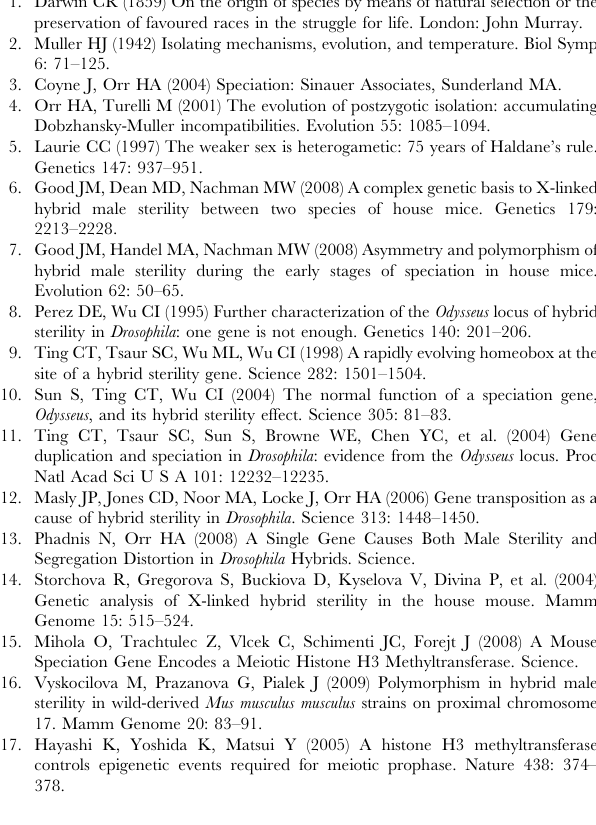
Figure S5 Multiple sequence alignment (shaded according to a 90% consensus) of 11 Capitella sp.I Prdm9 zinc finger sequences. These have been predicted from scaffold_236 of the Capitella sp.I v.1.0 genome assembly (Joint Genome Institute). Found at: doi:10.1371/journal.pgen.1000753.s005 (2.95 MB EPS) Figure S6 Multiple sequence alignment (shaded according to a 90% consensus) of Prdm9 zinc finger sequences from the Atlantic salmon ( Salmo salar ; accession ACN10800, supported by ESTs CX352799, GE785155, EG785159, and EG785158) and from the Pacific Ocean rainbow trout ( Oncorhynchus mykiss ; contig generated from ESTs CR372724, CX253406 1305997, CX253405, CX252076, CX251898, CX251897, and CX252077). Found at: doi:10.1371/journal.pgen.1000753.s006 (2.67 MB EPS) Dataset S1 Multiple sequence alignment of Prdm9 zinc fingers from all analysed species in FASTA format. Found at: doi:10.1371/journal.pgen.1000753.s007 (0.09 MB PDF) Dataset S2 Genbank accessions for rodent and human sequences Found at: doi:10.1371/journal.pgen.1000753.s008 (0.04 MB